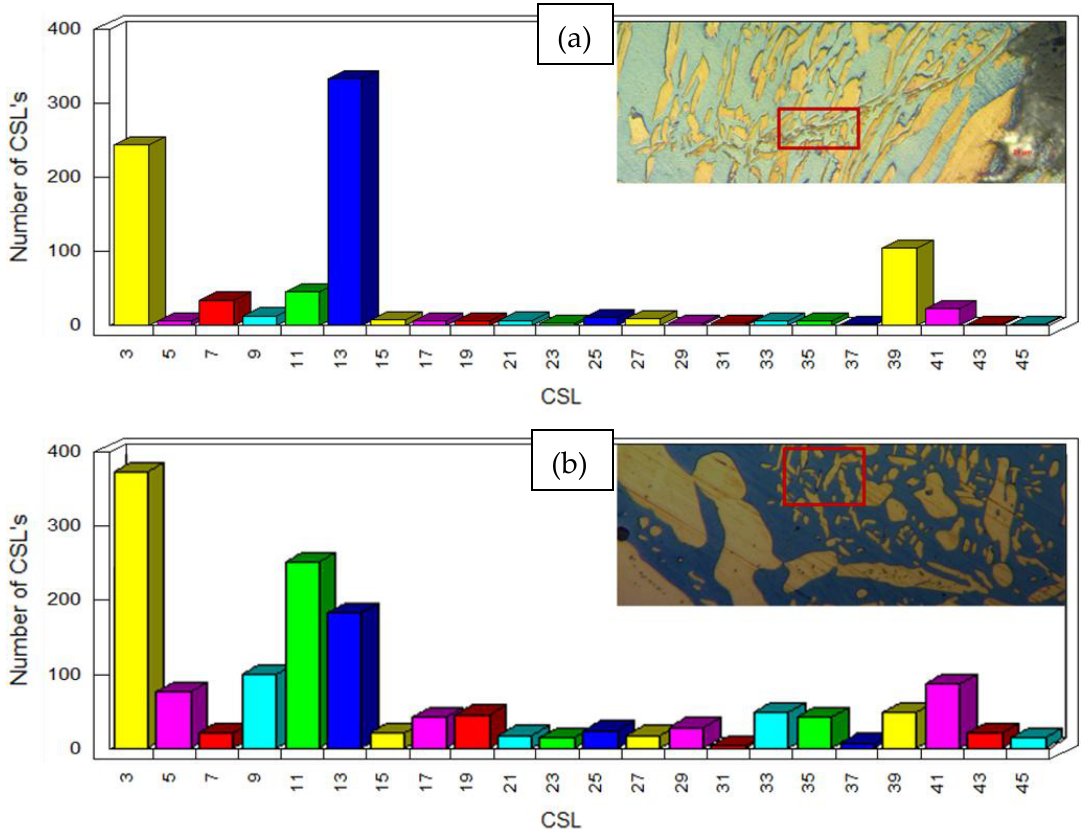
Figure 4. Comparison between CSL frequency occurrences of the martensitic shear γ -nuclei aligned to the dislocations structure shown in Figure 6 ( a ) and for other martensitic shear γ -precipitates present within un-deformed α -ferritic grains ( b ). The increase in CSL boundaries Σ 13, testifying to the occurrence of nucleation and growth phenomena, and thus, of transformation induced plasticity phenomena.